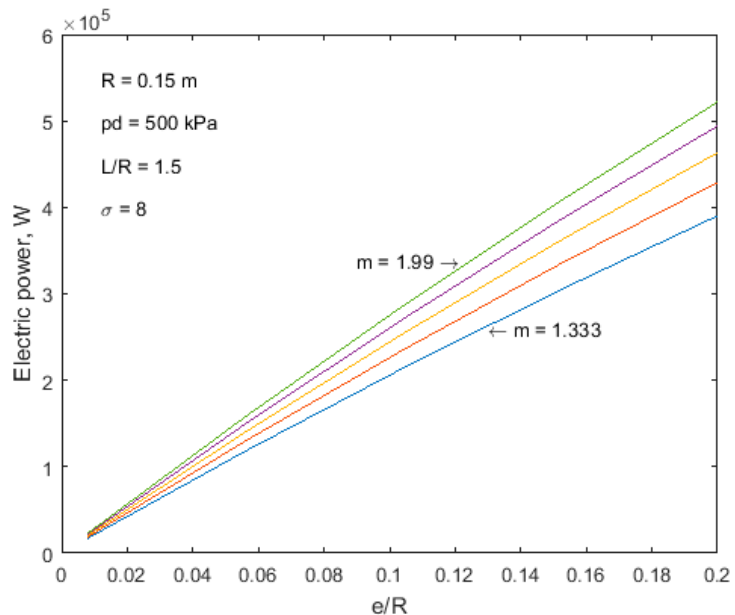
Figure 11. Electric power versus e / R ratio for different polytropic exponents ( m) , m = 1.333 (blue line), m = 1.4973 (red line), m = 1.6615 (orange line), m = 1.8258 (violet line), m = 1.99 (green line).